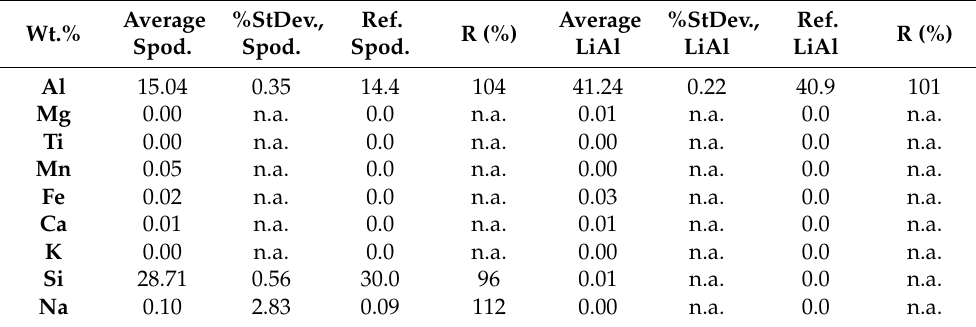
Table 1. Recovery of Li-compounds. Spod: spodumene, % StdDev: Relative standard deviation in percent, Repeats: N = 5, R: Recovery, LiAl: LiAlO 2 . Average %StDev., Ref. Wt.% Spod. Spod.